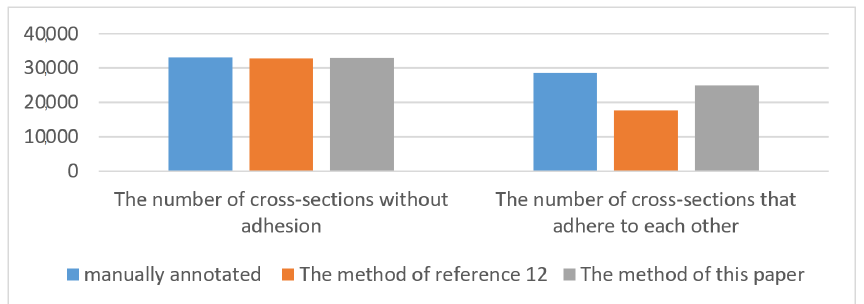
Figure 14. The comparison of edge detection effect between the method in this paper and the method in reference